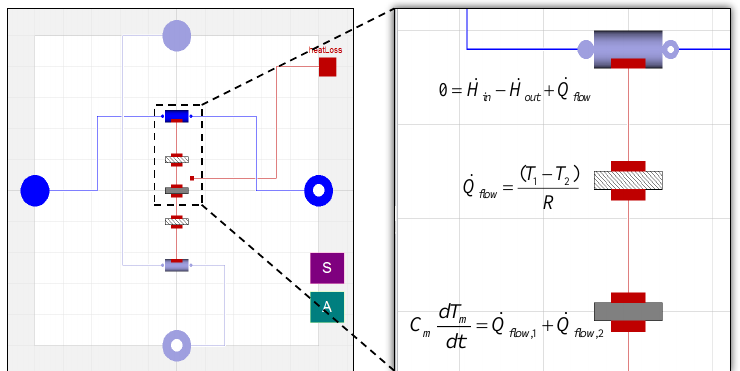
Figure 7. Exemplary visualization of the heat exchanger component model as a connection of the base models to model heat convection and heat conduction through a plate, with its physical